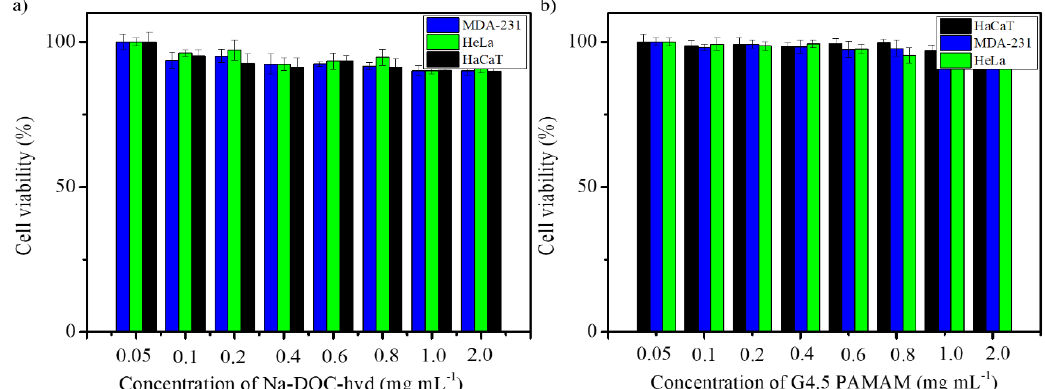
Figure8. Cytotoxicityofvariousconcentrationsof( a )Na-DOC-hydrogeland( b )G4.5poly(amidoamine) Figure 8. Cytotoxicity of various concentrations of ( a ) Na-DOC-hydrogel and ( b ) G4.5 dendrimer in HaCaT, HeLa, and MDA-MB-231 poly(amidoamine) dendrimer in HaCaT, HeLa, and MDA-MB-231 cells.